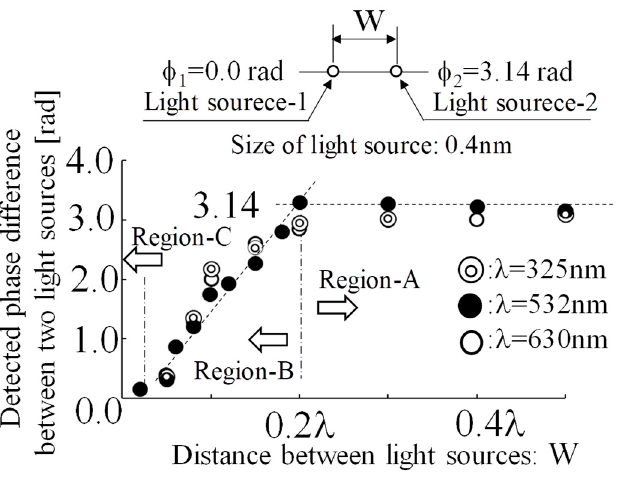
Figure 11. Relationship between the distance of light sources and the detected phase.